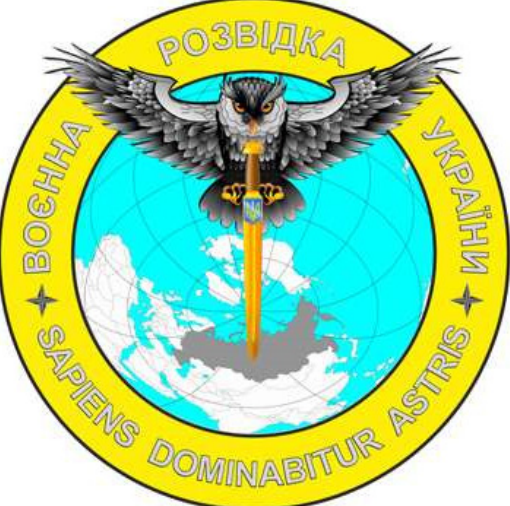
Figure 4. Emblem of the Main Directorate of the Ukrainian Defense Intelligence, 2016. Public Do- main.